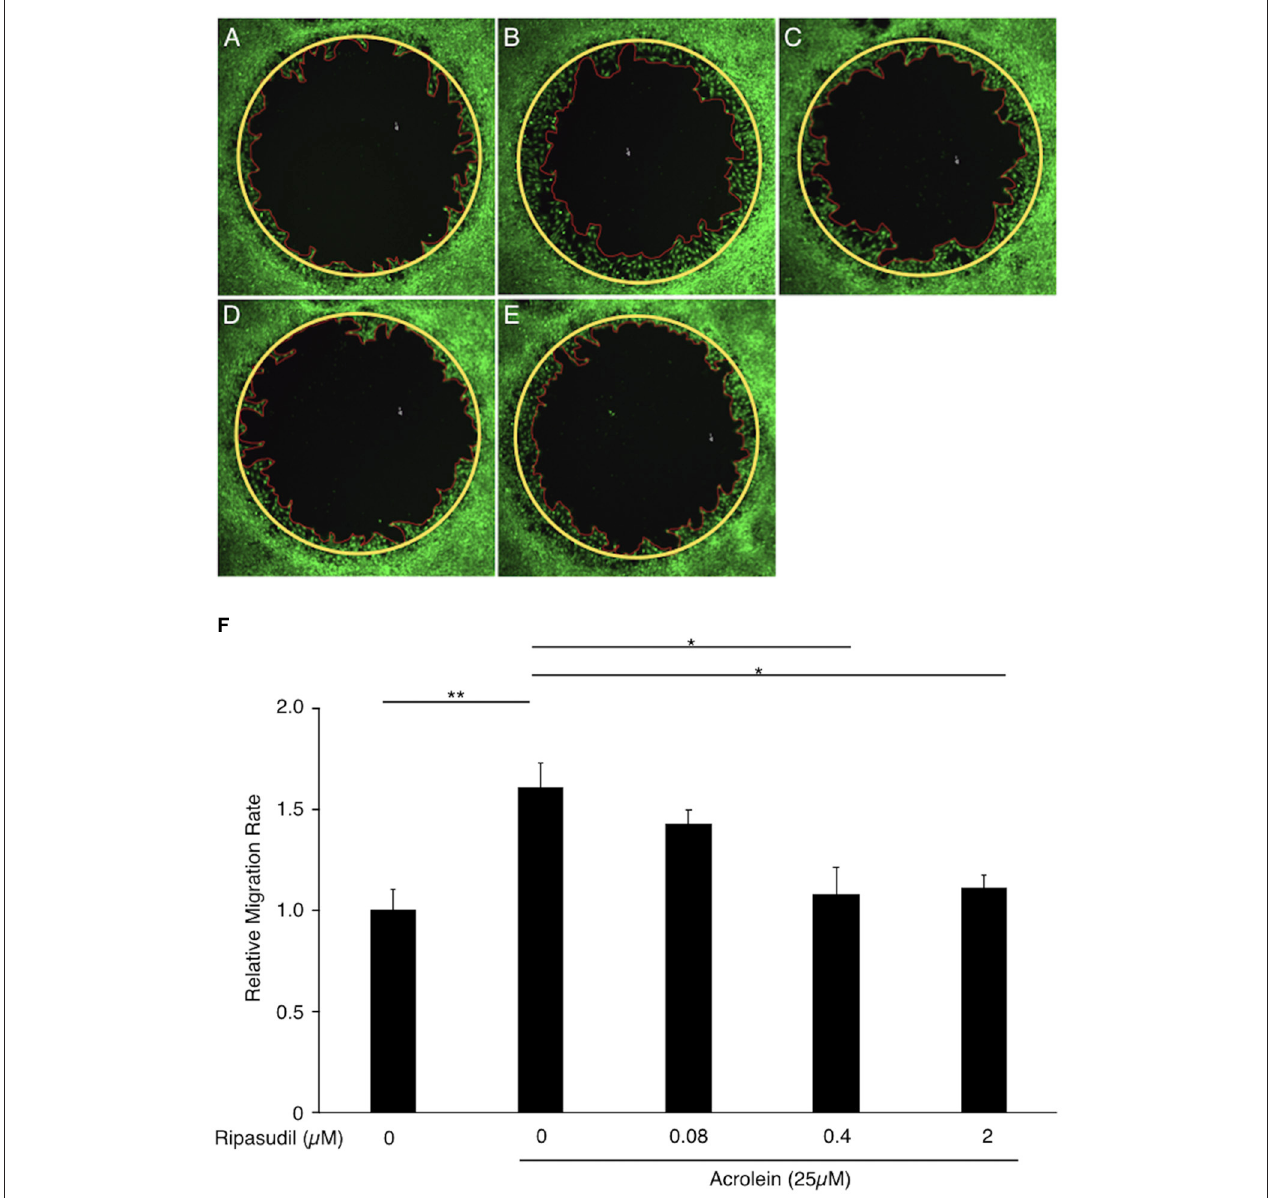
FIGURE 7 | Impact of ripasudil administration on acrolein-induced migration of TR-MUL5 cells. Representative micrographs of TR-MUL5 cell migration after acrolein stimulation with or without ripasudil treatment. (A) Control. (B) Acrolein stimulation (25 µ M). (C) Acrolein stimulation (25 µ M) with ripasudil (0.08 µ M). (D) Acrolein stimulation (25 µ M) with ripasudil (0.4 µ M). (E) Acrolein stimulation (25 µ M) with ripasudil (2 µ M). (F) Cell migration analysis in TR-MUL5 cells after acrolein stimulation with or without ripasudil ( n = 4 each). Values represent the mean ± SEM; * P < 0.05, ** P <